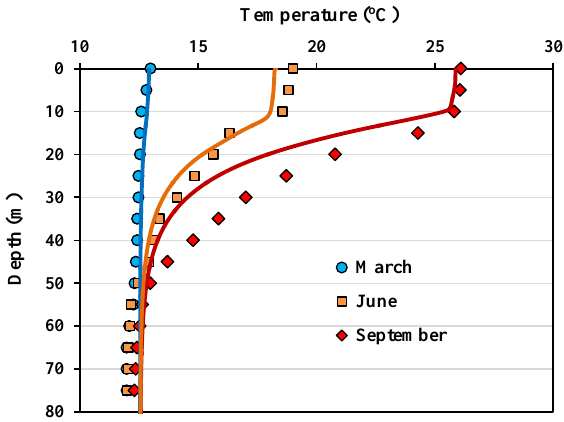
Figure 5. Model predictions (lines) and measurements (symbols) (Moreo and Swancar, 2013) of mean monthly vertical temperature profiles in Lake Mead; modeling results were obtained using mete- orological data measured at Lake Mead assuming radiation absorp- tion at the surface ( β ) and attenuation coefficients ( η ) of 0.3 and 0.1,